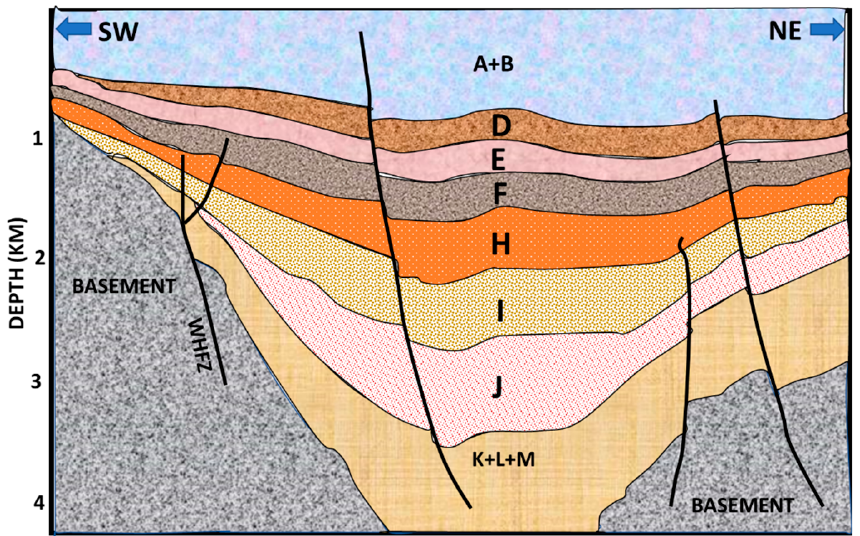
Figure 3. Schematic geologic cross-section, showing the sequence stratigraphic Groups and geologic structures of Malay Basin (redrawn by [39], after [40]).